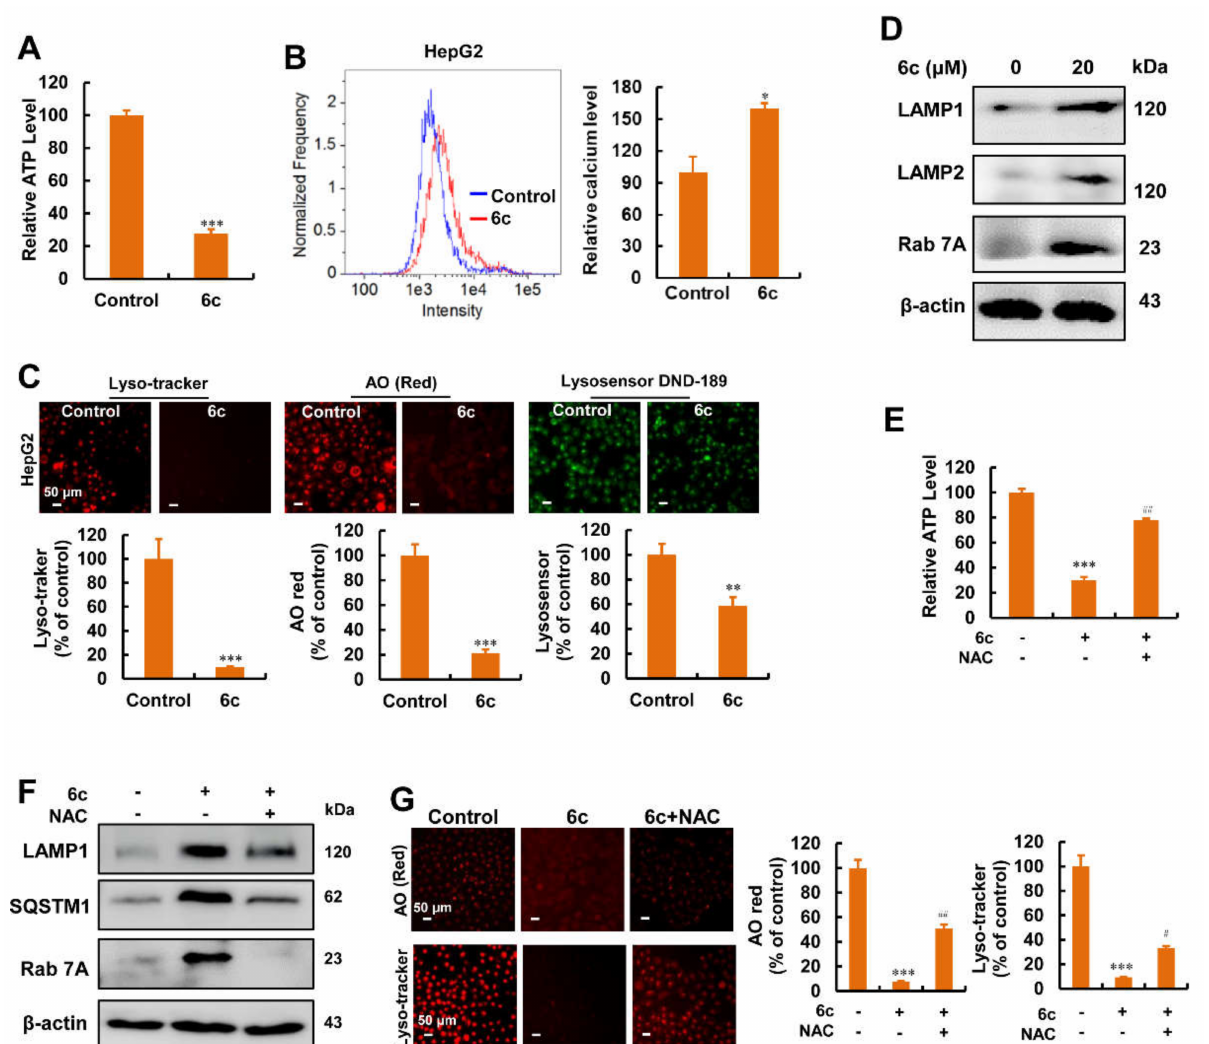
Figure 6. Compound 6c induced mitochondrial and lysosomal dysfunctions attributing to ROS overproduction. ( A ) 6c treatment resulted in ATP depletion. After treatment of 6c (20 µ M) for 6 h, HepG2 cells were collected and mixed with cell titer Glo reagents. Luminescence data were recorded by using monochromator microplate reader ( n = 3). ( B ) Flow cytometry analysis of mitochondrial calcium levels examined using Rhod 2 staining. Cells treated with 6c for 6 h were stained with Rhod 2 ( n = 3). ( C ) Statistical intensity of lysosome tracker, AO, and lysosensor DND-189 in 6c-treated cells. HepG2 cells were treated with 6c (20 µ M) for 6 h, the fluorescence intensity was detected using HCS ( n = 3). ( D ) The expression of proteins related to lysosomes was examined using Western blot. HepG2 cells were treated with 6c (20 µ M) for 24 h. ( E ) NAC pre-treatment increased ATP levels in 6c-treated cells. Cells were incubated with NAC (10 mM) for 1 h before 6c (20 µ M) treatment for another 6 h ( n = 3). ( F ) The expression of LAMP1, SQSTM1, and Rab 7A was determined using Western blot. HepG2 cells were pre-treated with NAC for 1 h followed by treatment with 6c (20 µ M) for 24 h. ( G ) NAC (10 mM) partially improved the decreased fluorescence intensity of AO and lyso-tracker red induced by 6c ( n = 3). * p < 0.01, ** p < 0.01 and *** p < 0.01 vs. control; # p < 0.05 and ## p < 0.01 vs. 6c treatment